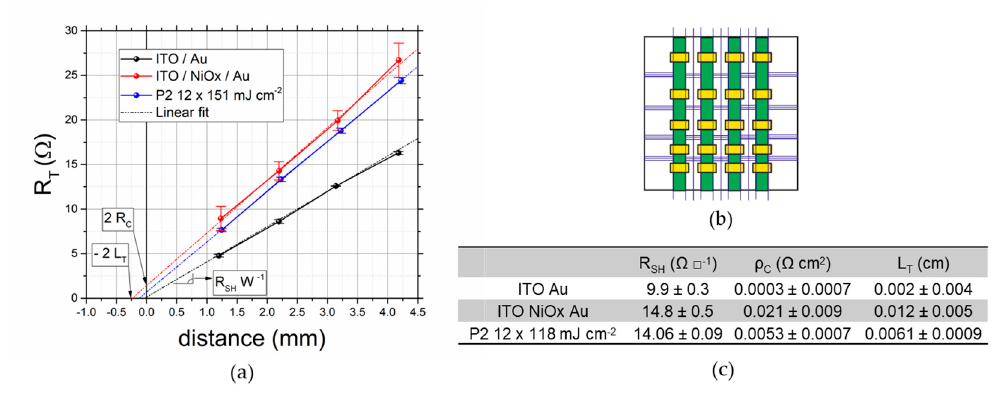
Figure 4. ( a ) Transfer length measurement (TLM) plot with an indication of the important parameters measure; ( b ) Design of the samples used for TLM: purple lines represent P1 scribes, yellow pads represent the gold contact and green pads indicate the four stripes used for TLM; ( c ) Summary table with the parameters measured in the TLM analysis.